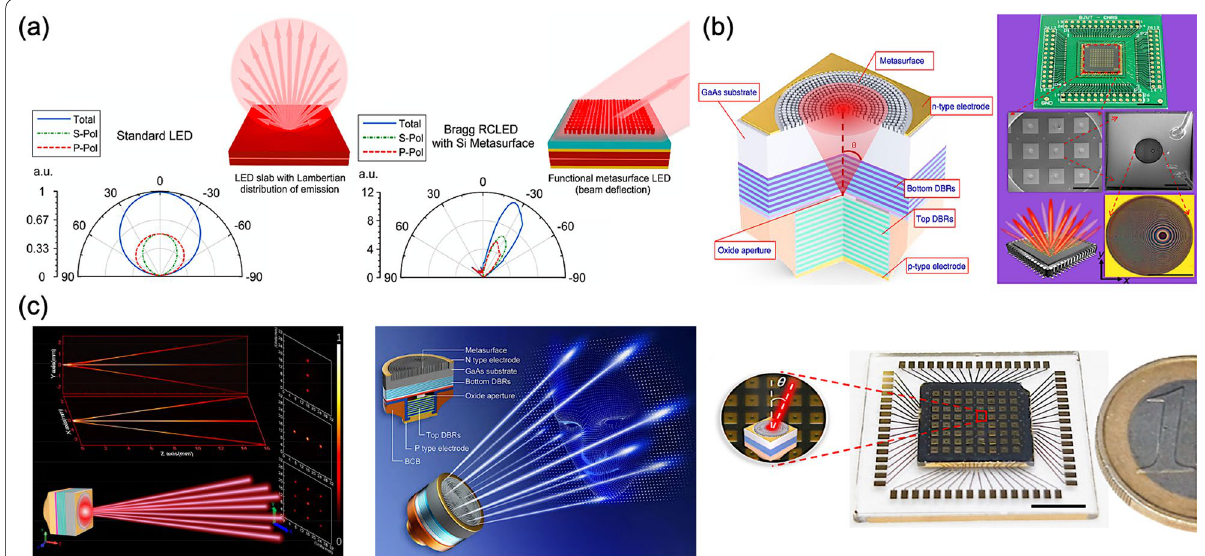
Fig. 11 Structured light projection with metasurface‑integrated devices a Wide angle Lambertian distribution of a plain LED slab (left), Controlled LED emission with functional dielectric metasurfaces (right) [126], b Schematic of a standard VCSEL structure integrated with a metasurface at the back side of the substrate (left), Metasurface‑integrated VCSELs for programmable directional lasing emissions (right) [142], and c Multichannel beams array generations (left), Ultracompact generating structured light on an on‑chip integration of metasurfaces and VCSELs (middle), Beam steering chip consisting of 8 8 laser elements with different deflection angles (right) ×